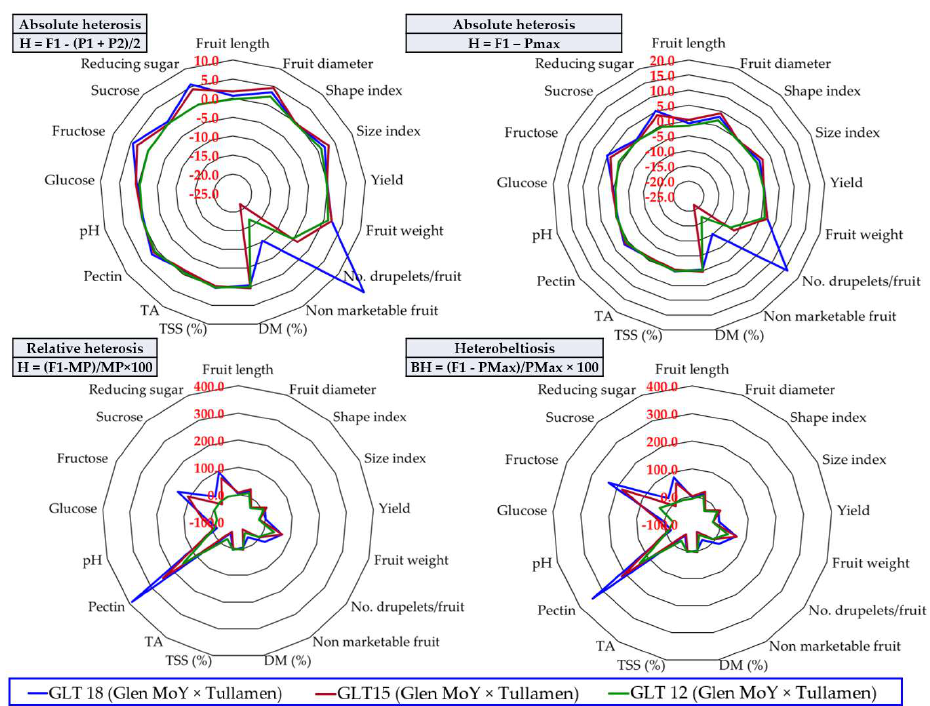
Figure 6. The heterosis effect upon the 17 analyzed characteristics in three promising selections ob- tained from the hybridization of Tulameen × Autumn Bliss.